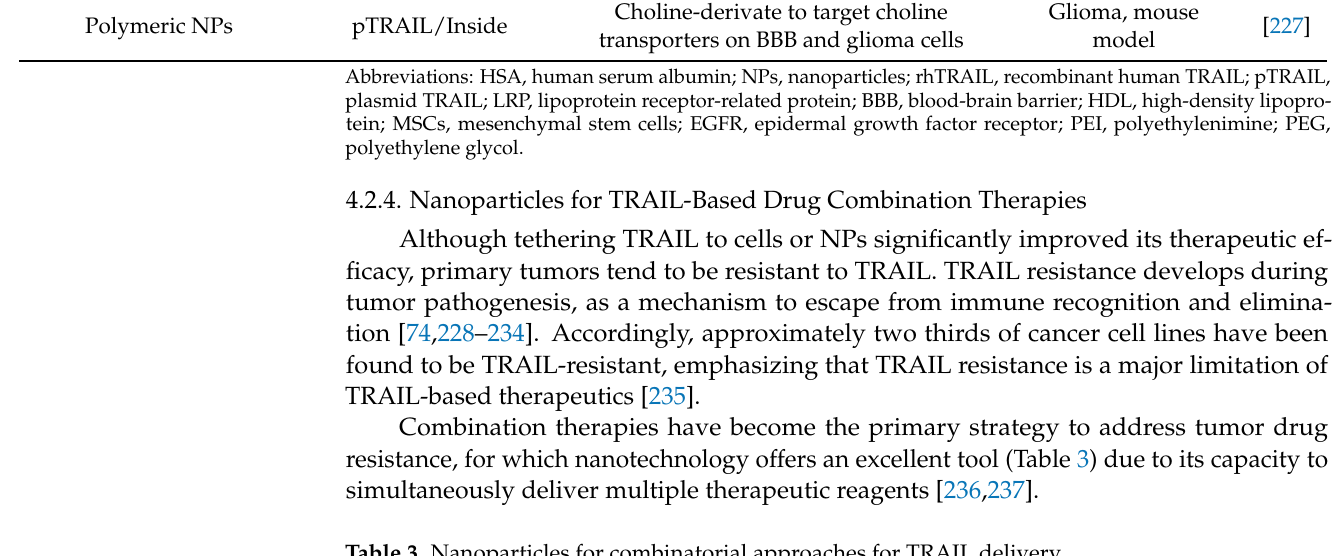
Table 3. Nanoparticles for combinatorial approaches for TRAIL